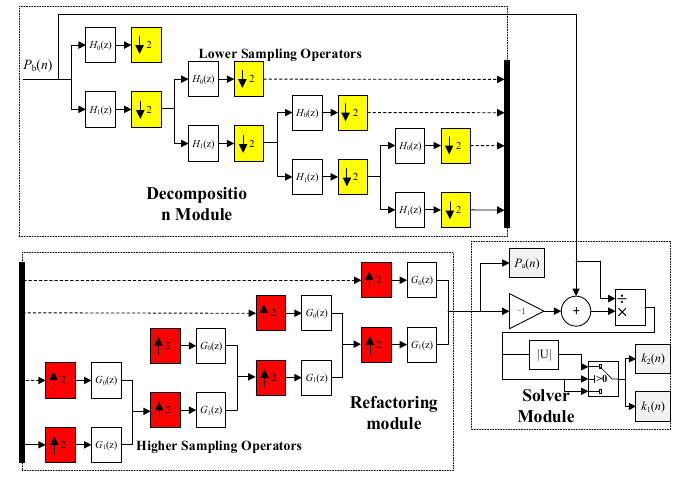
Figure 6. Block diagram of the power allocation.